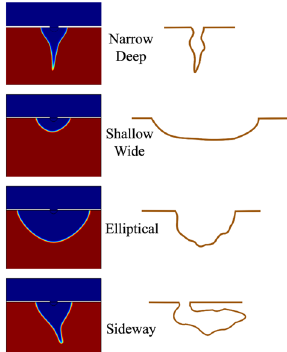
Figure 12. Different pitting shapes from simulations (left) and observations (right).